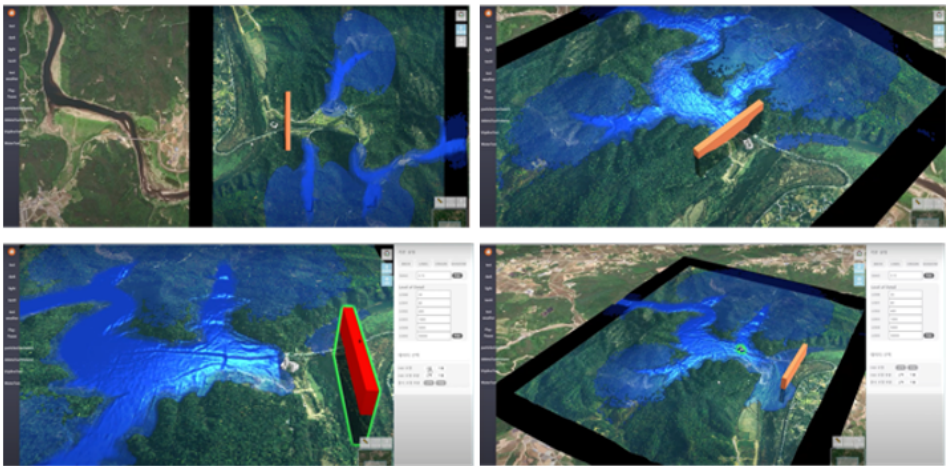
Figure 4. Interactive water simulation.